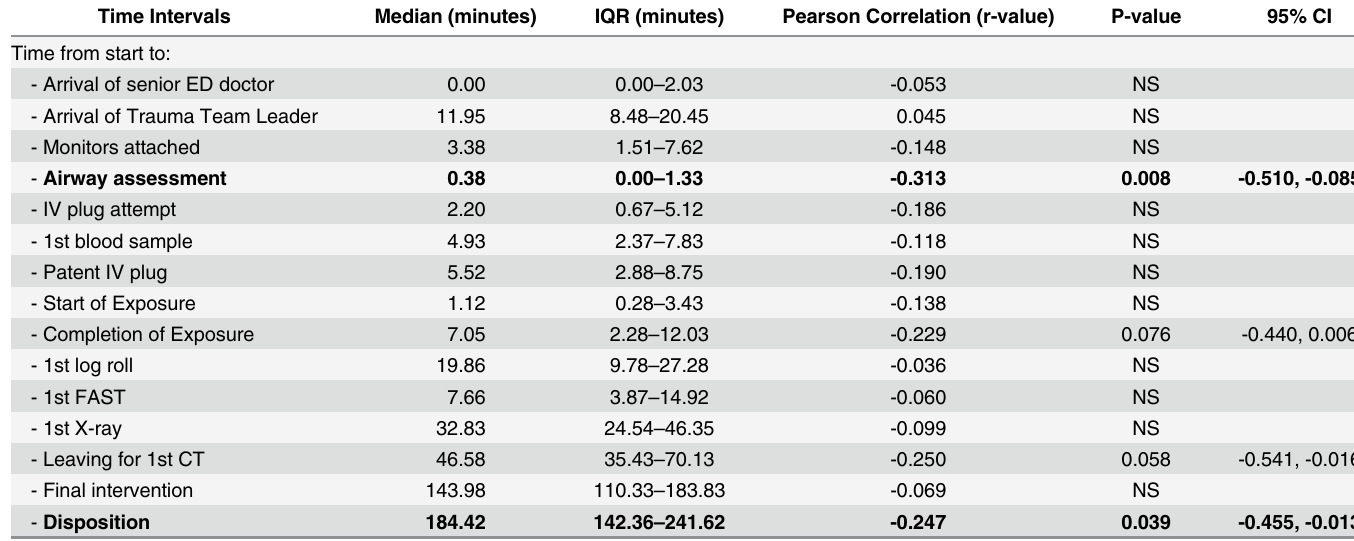
Table 2. Effect of Team Size Variation ( < 7 vs. (cid:1) 7) on Outcome and Time Interval Factors. Time Intervals